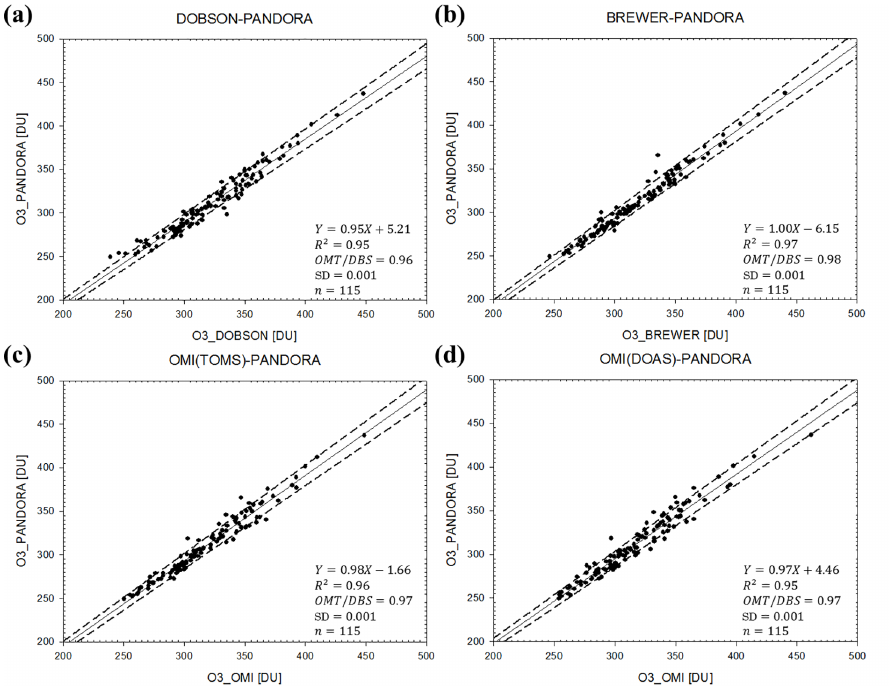
Figure 5. Intercomparison of daily TCO values from Pandora with Dobson (a) , Brewer (b) , and OMI (TOMS, c ; DOAS, d ). Solid lines represent regression lines, and dashed lines indicate an error range of ± 3%.